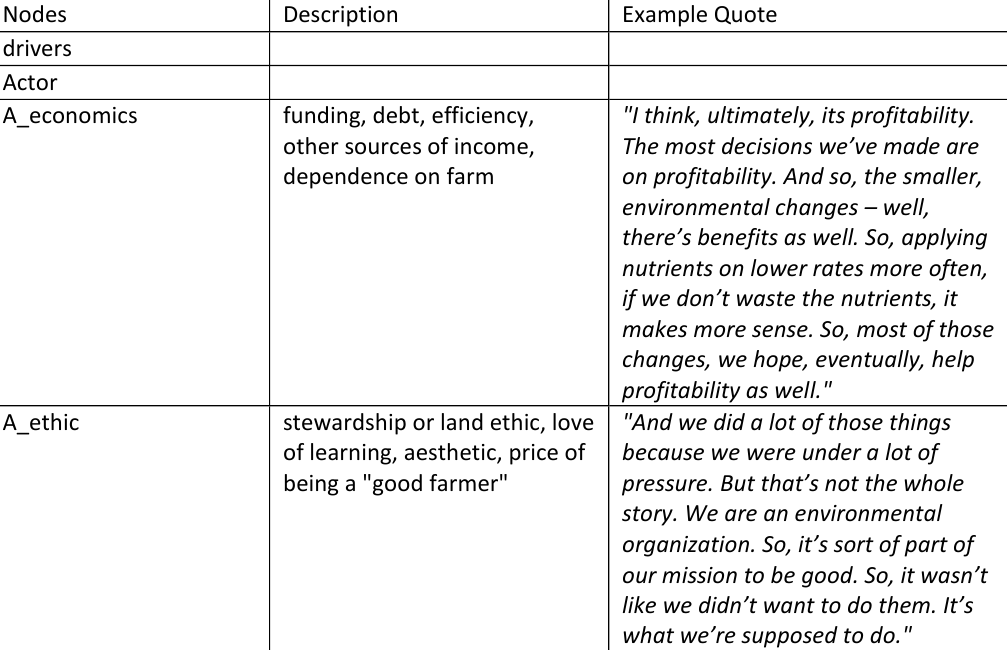
Table A1.2. Full codebook with descriptions and representative quotes